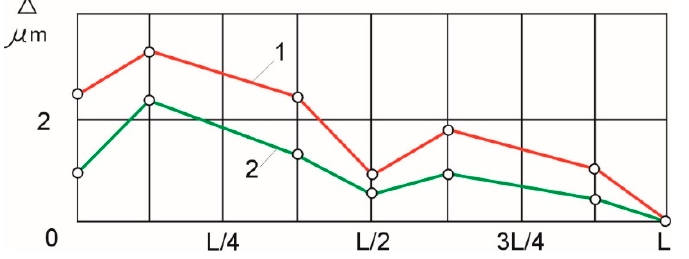
Figure 8. Shape deviations of samples d = 8 mm (1) and d = 14 mm (2), when bending moments were controlled.